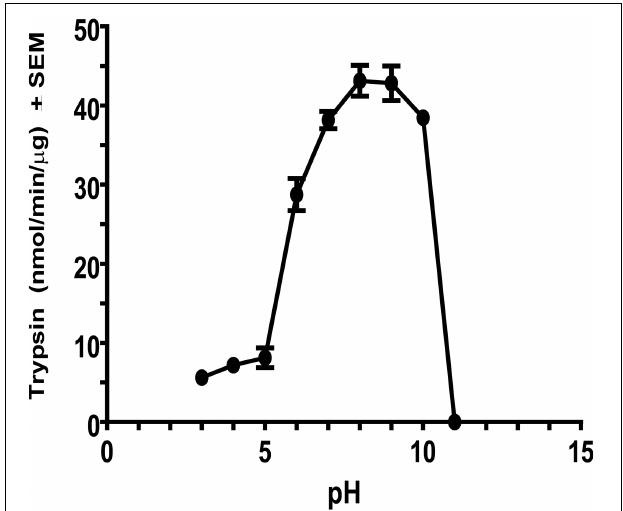
FIGURE 3 | Effect of pH on purified C. quinquefasciatus late trypsin activity. Fraction (100 µ l) from the combined trypsin peak after affinity